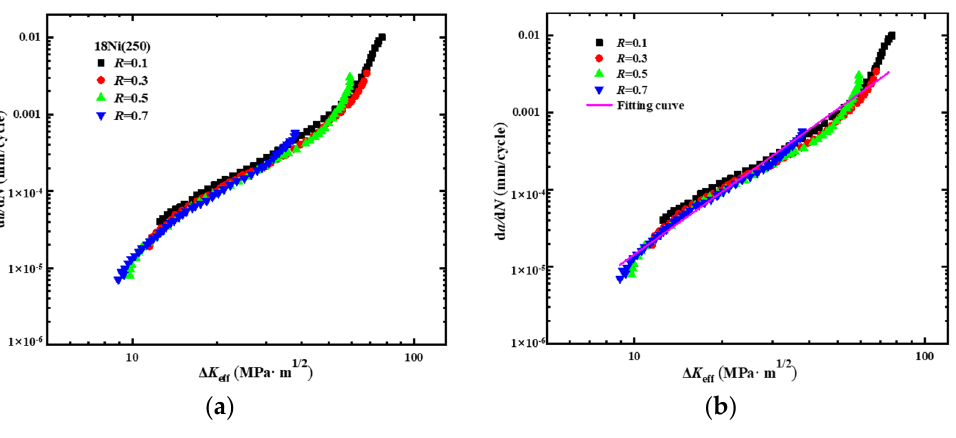
Figure 4. The 18Ni (250) fatigue crack growth rate reference curve. ( a ) Processed curve; ( b ) Fitted